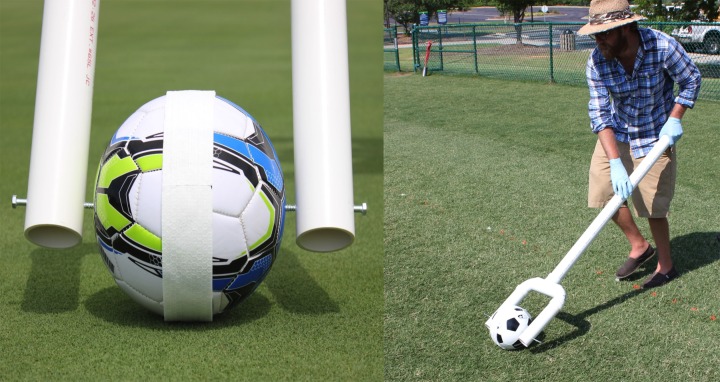
Soccer Ball Roller Apparatus for Dislodge Sampling.Frame constructed of PVC (5 cm inner diameter) and lag bolts to mount a soccer ball, which allows for a consistent end-over-end ball roll and constant sorbent strip-to-turfgrass contact.